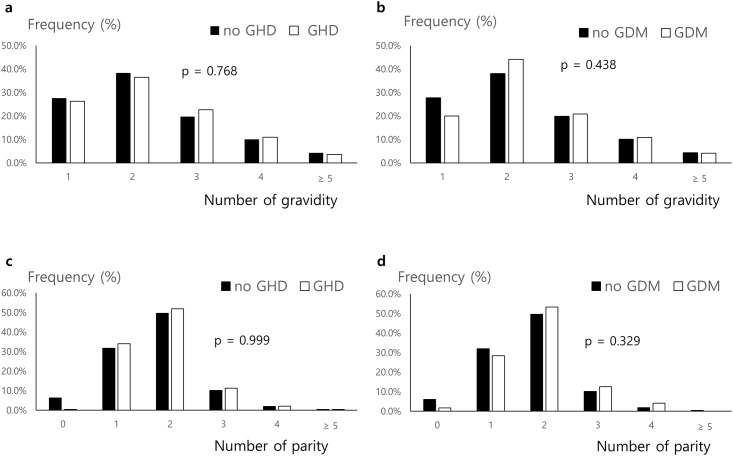
Gravidity and parity of the study subjects.(A) Histogram of the number of gravidity in subjects with GHD or no GHD. (B) Histogram of the number of gravidity in subjects with GDM or no GDM. (C) Histogram of the number of parity in subjects with GHD or no GHD. (D) Histogram of the number of parity in subjects with GDM or no GDM.